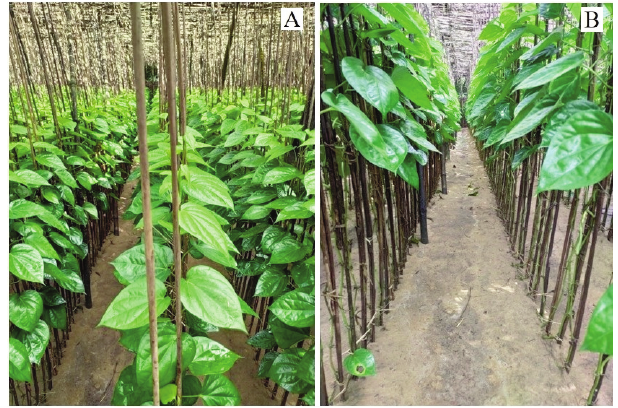
Fig. 3 ­ Cultivation and propagation of Piper betle inside the Baraja at Bhograi area of Balasore district, Odisha